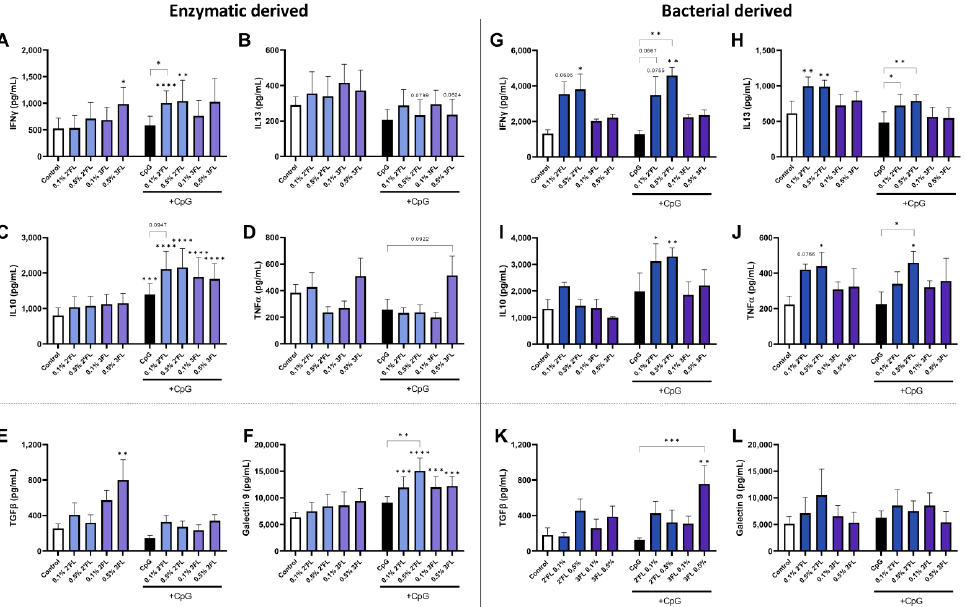
Figure 4. 24 h after preincubation of IEC with HMOS, IEC were cocultured with activated PBMCs for another 24 h, while fresh HMOS and/or CpG were added to the apical compartment of the transwell. After this coculture, cytokine secretion was measured in the basolateral compartment. Inserts containing IEC were transferred to a new plate, HMOS and CpG were washed away and IEC were cultured for another 24 h to detect epithelial derived TGF β and galectin-9 in the basolateral compartment. Release of ( A ) IFN γ , ( B ) IL13, ( C ) IL10 and ( D ) TNF α upon coculture of IEC and activated PBMC while exposing IEC to enzymatic derived 2 (cid:48) FL and 3FL, as well as IEC derived ( E ) TGF β and ( F ) galectin-9 after coculture. In addition, release of ( G ) IFN γ , ( H ) IL13, ( I ) IL10 and ( J ) TNF α upon coculture of IEC and activated PBMC while exposing IEC to bacterial derived 2 (cid:48) FL and 3FL, as well as IEC derived ( K ) TGF β and ( L ) galectin-9 IEC after coculture. Data is analyzed by One-Way ANOVA followed by a Bonferroni post-hoc test, n = 9 for synthetically produced HMOS, n = 3 for bacterial produced HMOS, mean ± SEM (* p < 0.05, ** p < 0.01, *** p < 0.001, **** p < 0.0001). When the coculture was performed with bacteriall y derived 2 (cid:48) FL and 3FL, different cytokine secretion profiles were found. Both concentrations of 2 (cid:48) FL enhanced IFN γ and IL13, both in the presence or absence of CpG compared to the medium or CpG alone (Figure 4G,H). In addition, 0.5% 2 (cid:48) FL also significantly enhanced TNF α levels